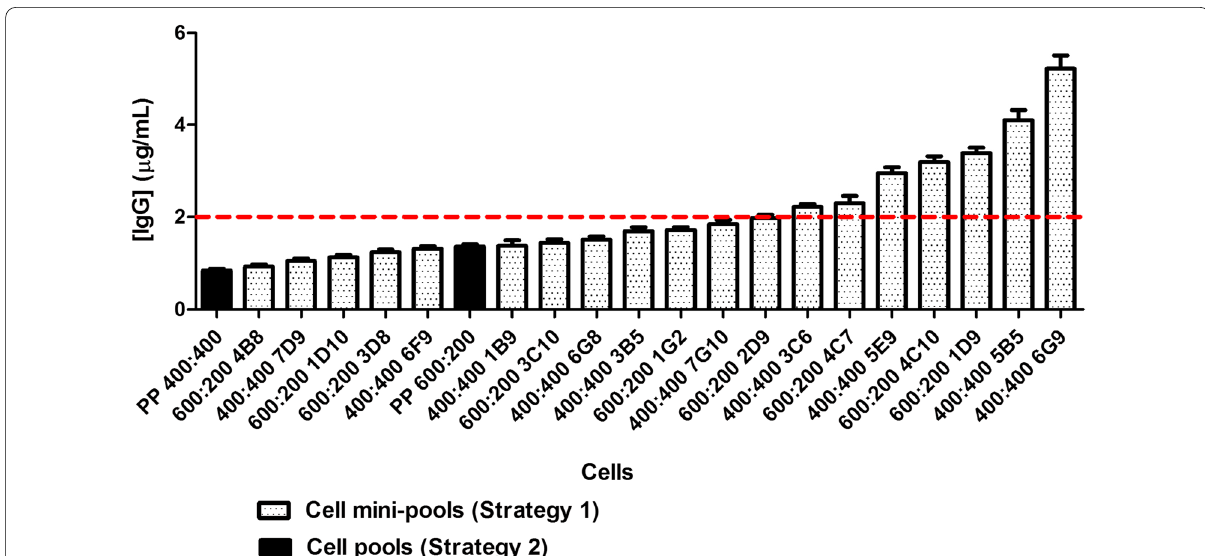
Fig. 4 Evaluation of IgG expression levels of cell pools and mini‑pools in 24 well plate assay. Producing cells were seeded in 24 well plate, at 0.4 x 10 6 cells/well in 1 mL of CP‑CHO‑CB5‑FBS medium. The experiment was performed in triplicates. Plates were incubated at 37 °C in the presence of 5% CO 2 . The concentration of IgG in cell culture supernatants after 10 days, was measured by ELISA (whole antibody detection). To quantify the expression levels, a standard curve was made using known amount of trastuzumab. The data correspond to mean indicates the average level of IgG for the evaluated supernatants